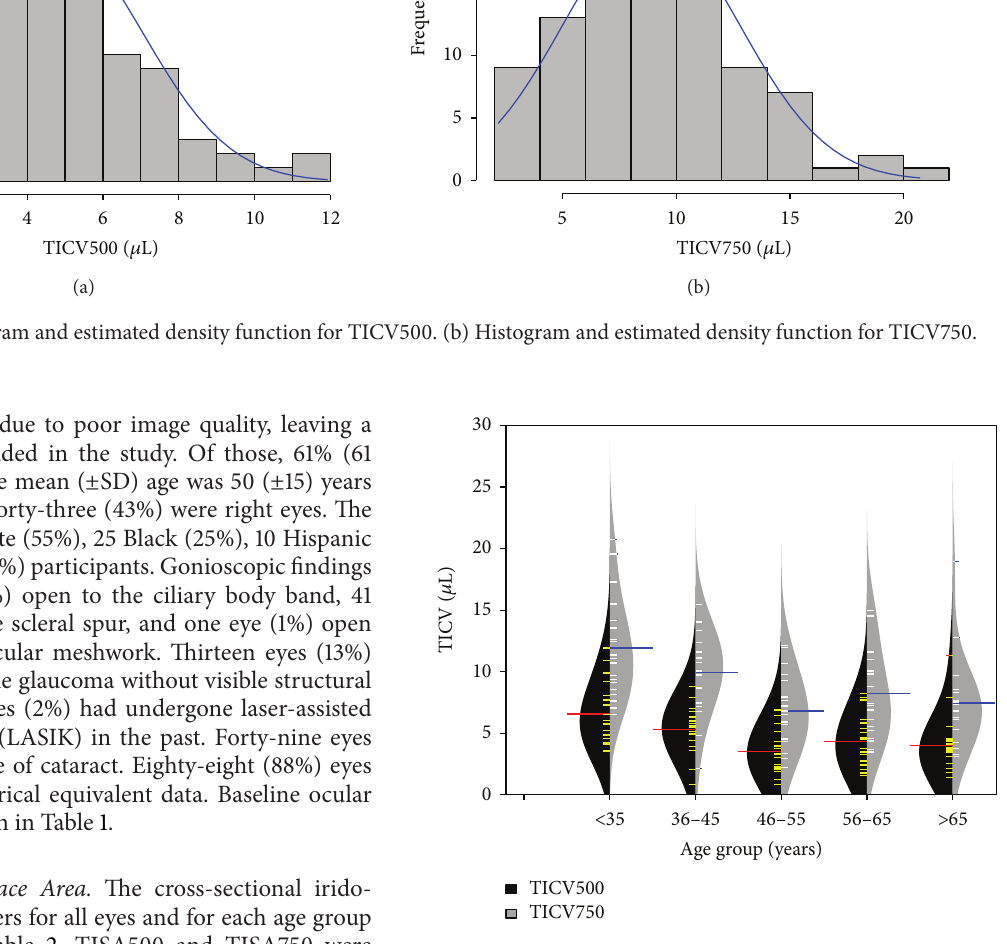
Figure 3: Observed TICV500 (yellow) and TICV750 (white), estimated normal density functions (black for TICV500 and grey for TICV750), as well as means (red for TICV500 and blue for TICV750) for each age